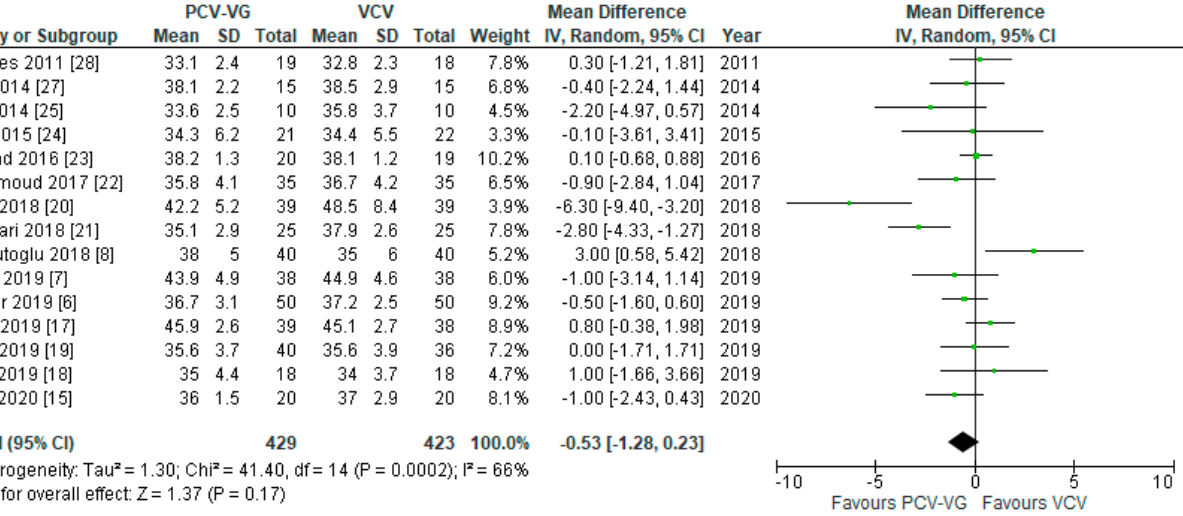
Figure 9. Arterial carbon dioxide pressure (P a CO 2 ): supine, two-lung ventilation. The green center of each square represents the weighted mean difference for individual trials, and the corresponding horizontal line stands for a 95% confidence interval. The diamonds represent pooled results.